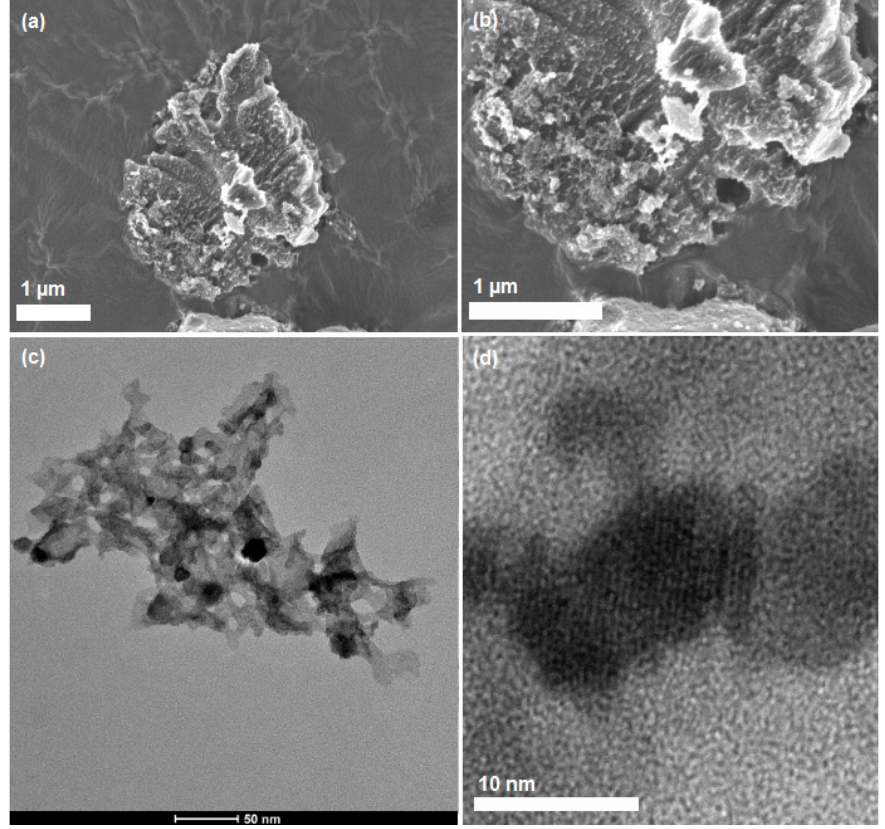
Figure 1. Field emission scanning electron microscopy (FESEM) micrographs of CNHP500-2(2-1) in ( a ) 5000× and ( b ) 10,000× magnifications. ( c , d ) TEM images of sample CNHP500-2(2-1).